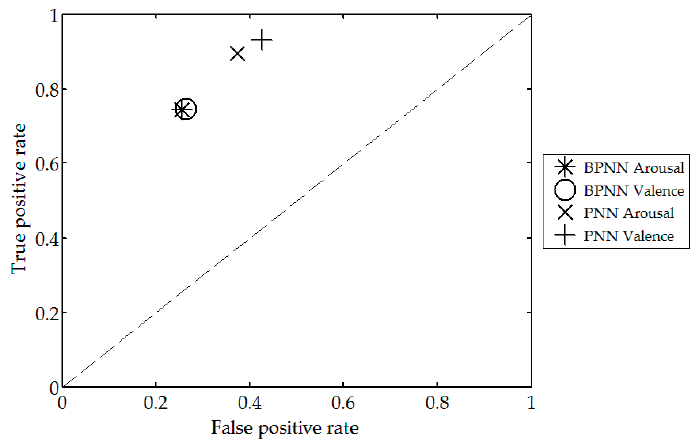
Figure 7. ROC plot of BPNN and PNN as the classifier.